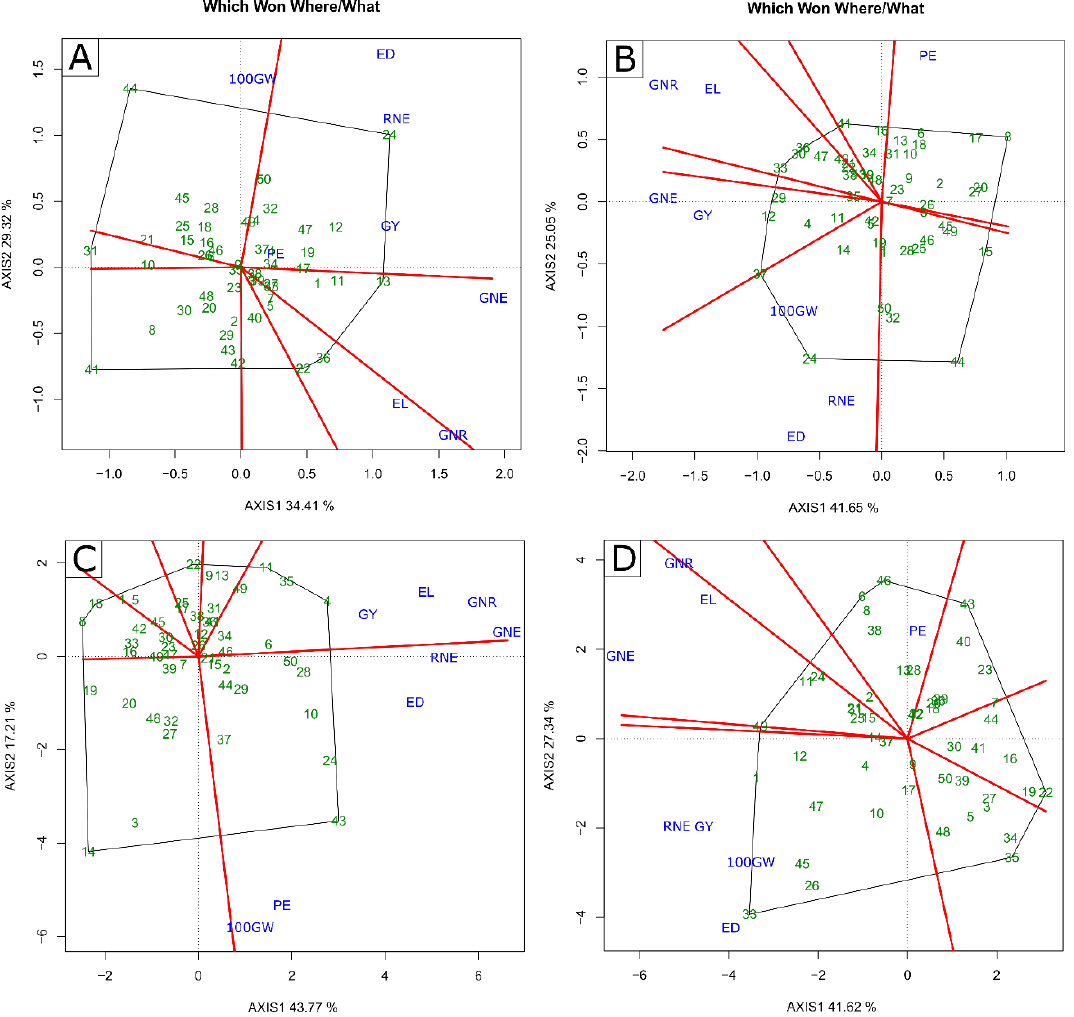
Figure 2. Biplot “which-won-where/what” graph for ( A – C ) water stressed (WS) and ( B – D ) well- watered (WW) conditions in 2020 ( A , B ) and 2021 ( C , D ) crop seasons. GY — grain yield; PE — Popping expansion; GNE — grain number per ear; 100 GW — 100-grain weight; RNE — Row number per ear; GNR — Grain number per row; ED — Ear diameter; EL — Ear length; (-) signal indicating negative values.